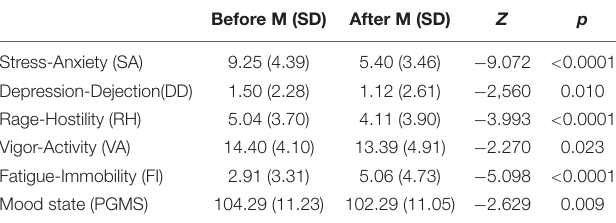
TABLE 2 | Scores obtained on the POMS scales before and after the choreography, in the 2nd phase (2 months later). Before M (SD) After M (SD)